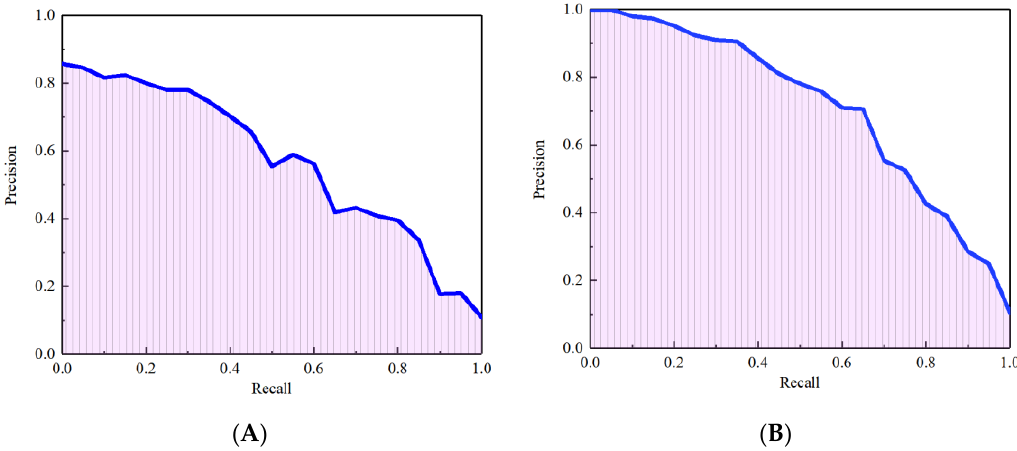
Figure 8. Precision recall curve: ( A ) is the PRC of SVR, and ( B ) is the PRC of CNN.